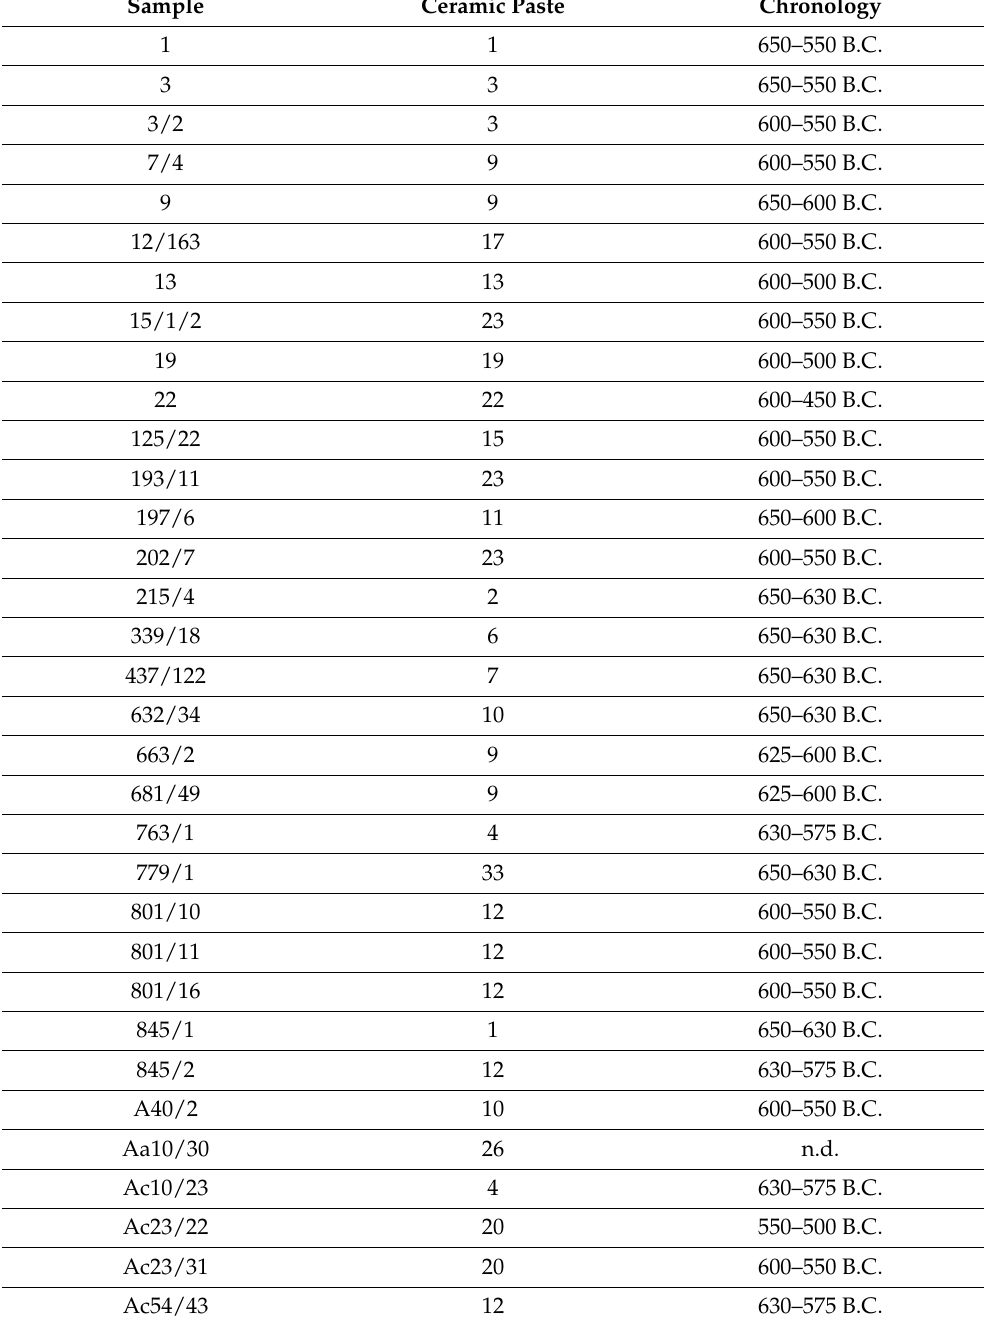
Table 1. Bucchero samples from the excavation of La Civita di Tarquinia. For each sample, the inventory number, the codex of the ceramic paste (see Table 2) and the chronology are reported. Legend: n.d. = not